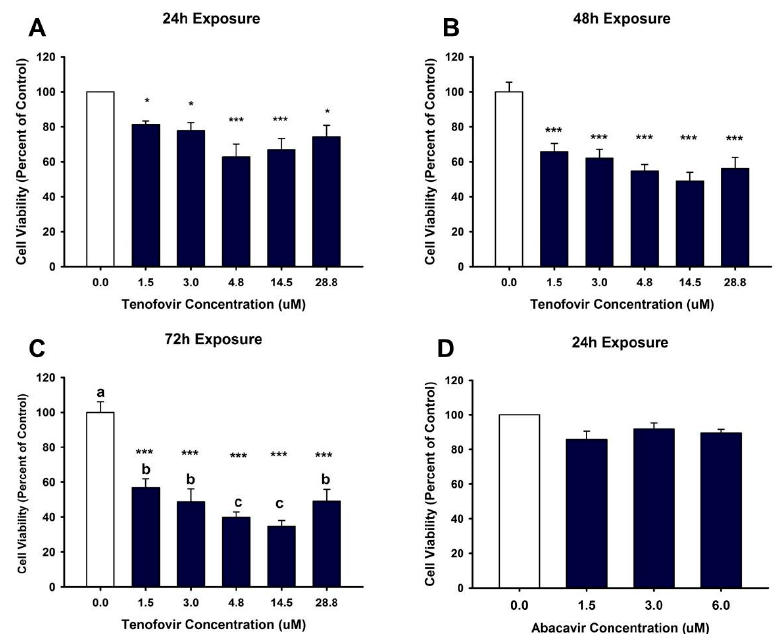
Figure 1. Tenofovir cytotoxic effects on cell viability in HK-2 cells using MTT (MTT, 3-(4,5-dimethylthiazol-2-yl)-2,5-Diphenyltetrazolium Bromide). Tenofovir diminished cell viability at 24 ( A ), 48 ( B ) and 72 h ( C ). Statistical difference from 0 μ M tenofovir depicted in ( A , B ) by asterisks (* p < 0.05, *** p < 0.001). Different superscript letters ( C ) indicate groups that are different from each other ( p < 0.05); ( D ) depicts cell viability following exposure for 24 h to another antiviral agent, abacavir. Abacavir did not alter viability at the concentrations tested. Each bar represents Mean ± SEM for three independent experiments run with two biological replicates.